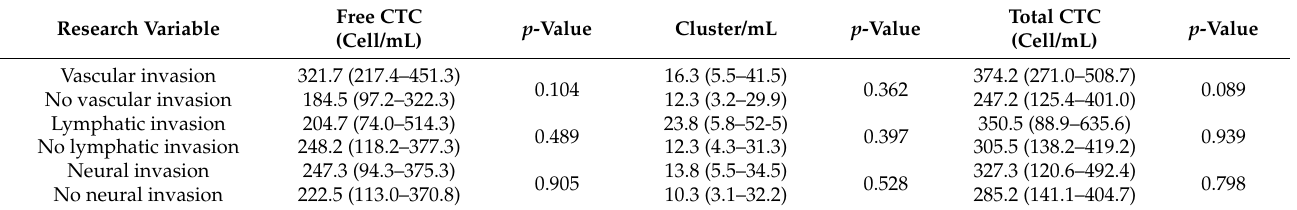
Table 7. Correlation of CTC and CTC clusters with microscopic invasion (PV